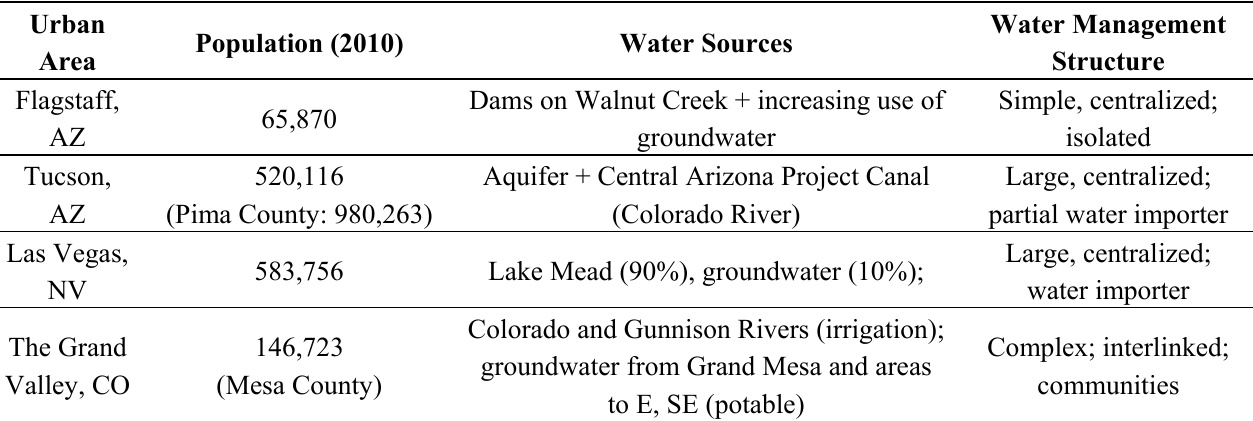
Table 1. Study areas and